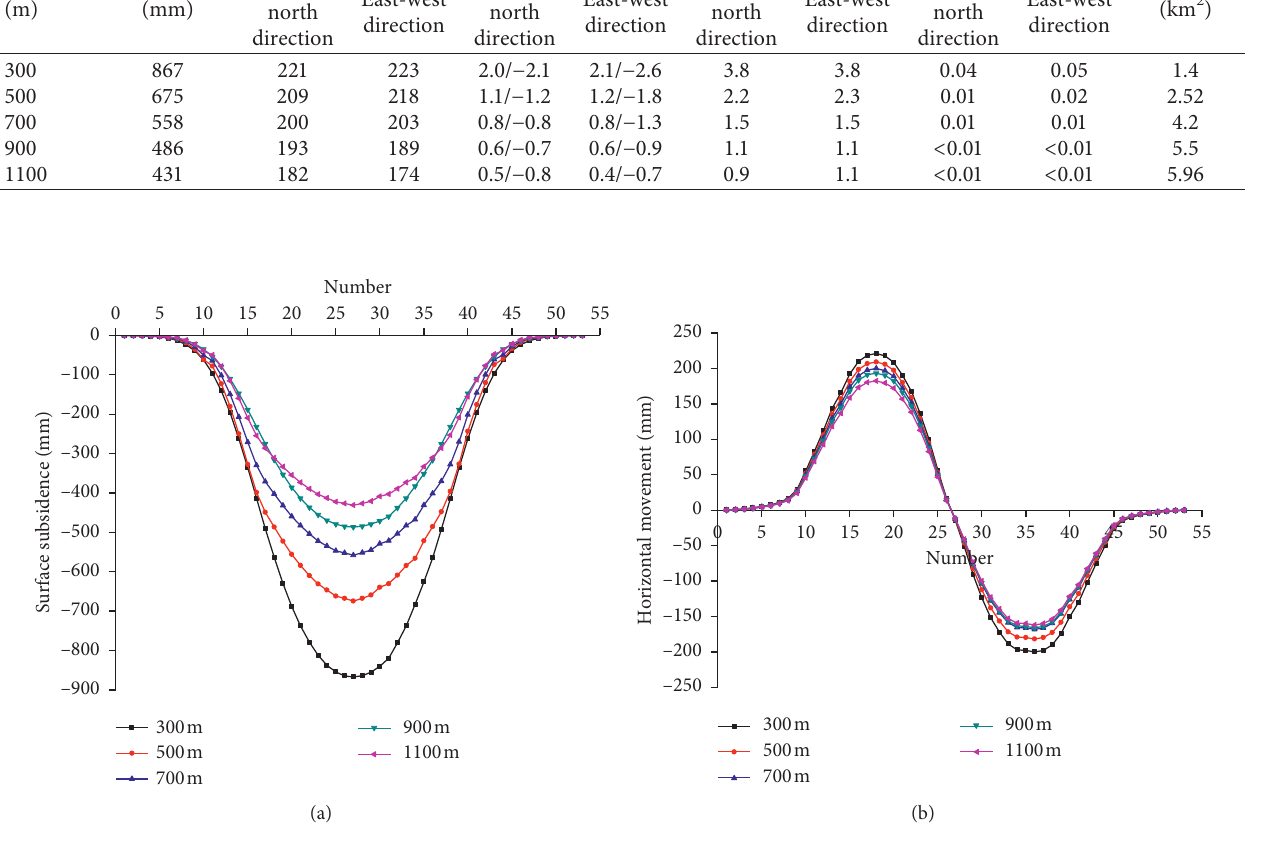
Figure 2: The influence of mining depth on the surface movement in deep backfill